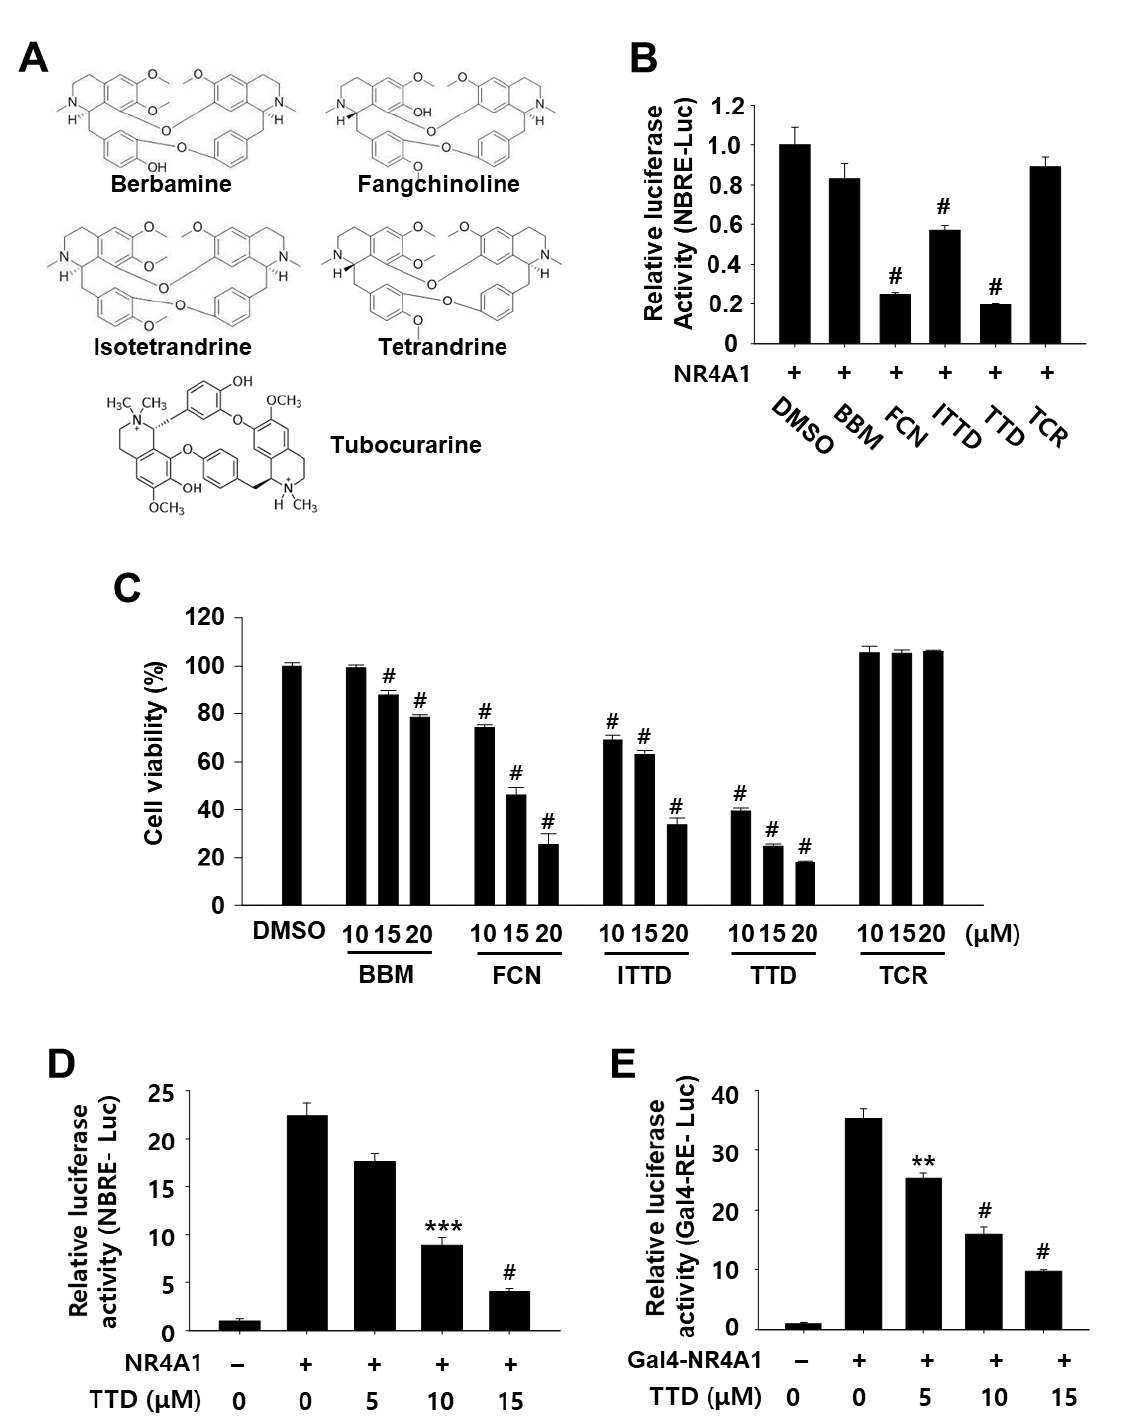
Figure 1. Effects of FCN and its analogs on NR4A1-dependent transactivation and cell proliferation in Panc-1 cells. ( A ) Chemical structure of FCN and its analogs. ( B , D ) Cells were cotransfected with NBRE-Luc (25 ng) and Flag-NR4A1 (12.5 ng) for 5 h, and then treated with each compound (20 µ M) for 18 h. ( C ) Cells were treated with various concentrations of each compound for 24 h, and cell viability was determined as described in the Materials and Methods section. ( E ) Cells were cotransfected with Gal4-RE-Luc (25 ng) and 5 ng of Gal4-NR4A1 (wild type) for 5 h, and then treated with TTD for 18 h. Luciferase activity (relative to β -galactosidase) was determined, and the corresponding empty vector was used as a control. The results are presented as means ± SEM ( n ≥ 3 replicates). ** p < 0.01, *** p < 0.005 and # p < 0.001 vs. DMSO, DMSO + NBRE-Luc, or DMSO + Gal4-NR4A1.